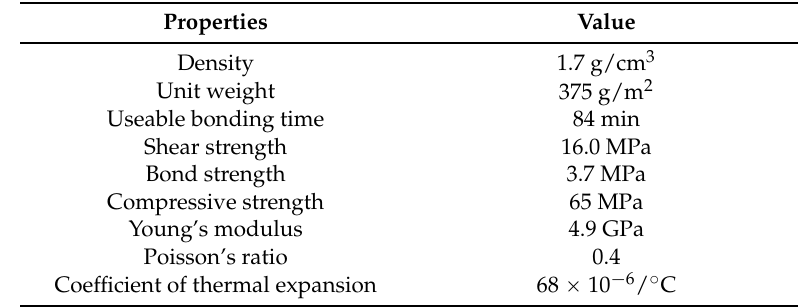
Table 1. Nominal material properties for steel beam and CFRP. Table 2. Properties of epoxy adhesive.